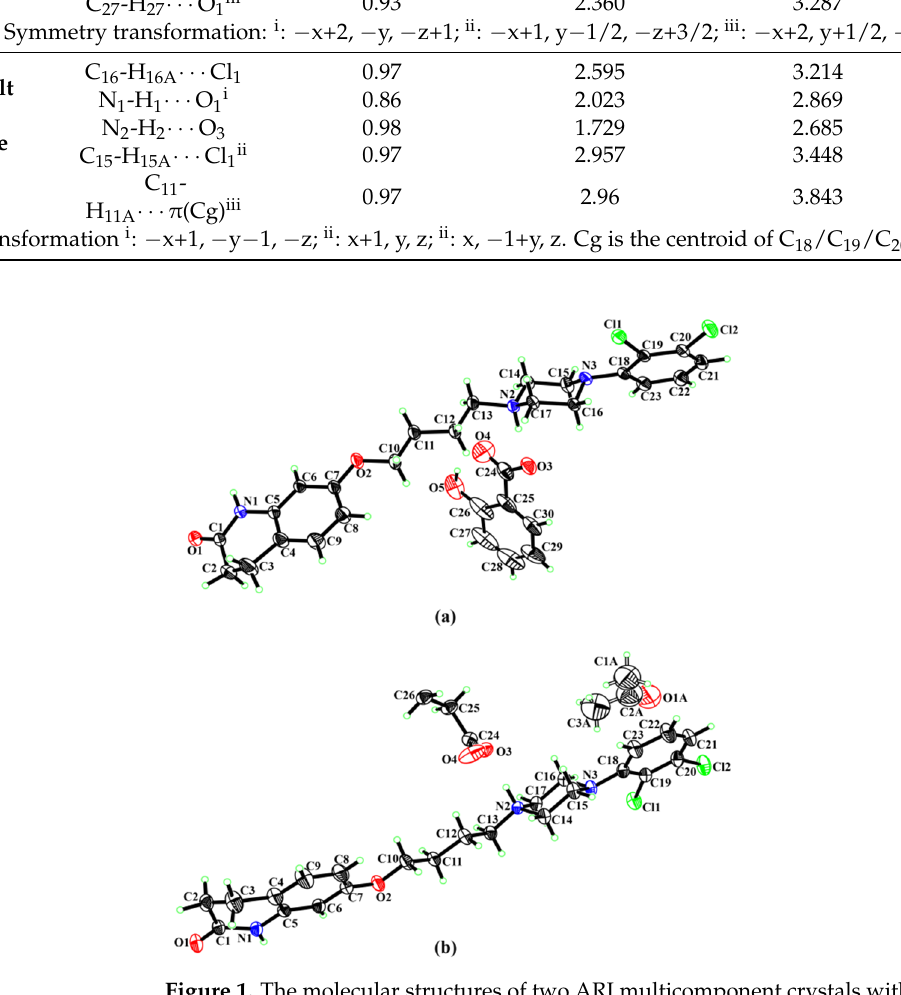
Figure 1. The molecular structures of two ARI multicomponent crystals with displacement ellipsoids drawn at the 30% probability level: ( a ) ARI-SAL salt; ( b ) ARI-ADI salt acetone hemisolvate. ARI-ADI salt acetone hemisolvate. The ARI-ADI salt acetone hemisolvate crystal- lized in the triclinic P-1 space group. The ORTEP diagram contained an aripiprazole cation, half of an adipic acid counter-ion (bisected by an inversion center), and half of an acetone molecule (Figure 1b). The solvent acetone molecule was disordered with a position occupancy of 0.5 due to the location on the symmetric center, and acted as a filler in spatial network. The centrosymmetric N 1 -H 1 · · · O 1 dimer R 2 (8) motif with its inversion-related 2 molecule also can be found and formed a 1D ribbon by the strongest charged N 2 + -H 2 · · · O 3 hydrogen bond (Figure 3a). The 1D ribbon interacted with its adjacent ribbon and then formed a 2D sheet through a C 15 -H 15A · · · Cl 1 hydrogen bond (Figure 3b). Finally, the 2D sheets were arranged into the three-dimensional network by a weak C 11 -H 11A · · · π hydrogen bond (Figure